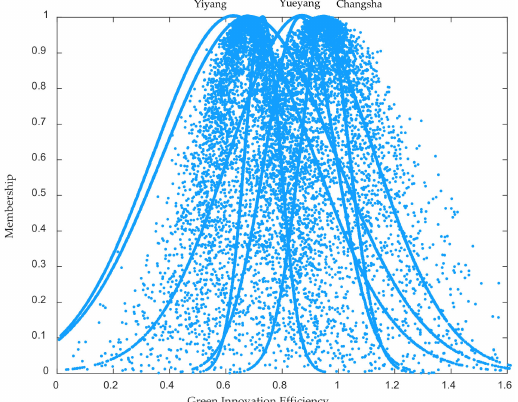
Figure 3. Normal cloud-membership degree distribution of green innovation efficiency in the Great Changsha-Zhuzhou-Xiangtan City